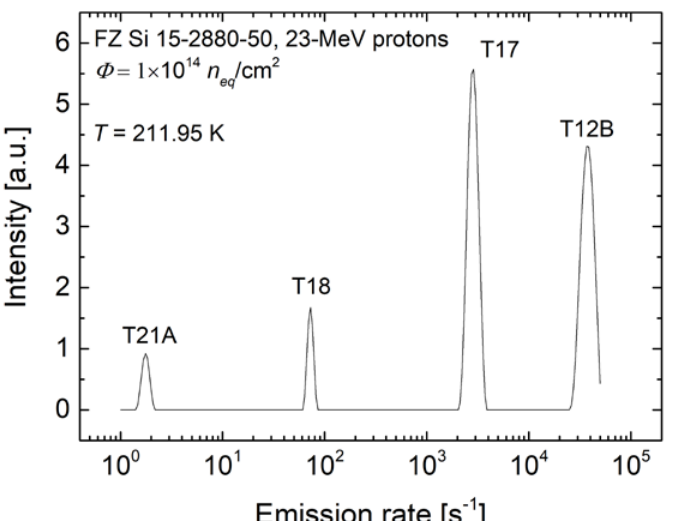
Figure 1. Laplace spectrum derived from the photocurrent relaxation waveform recorded at 211.95 K for a HPSi sample after irradiation with a fluence of 1 × 10 14 n eq /cm 2 of 23-MeV protons. Four sharp peaks indicating the thermal emission rate values for the irradiation-induced deep traps labeled as T12B, T17, T18, and T21A are visible.